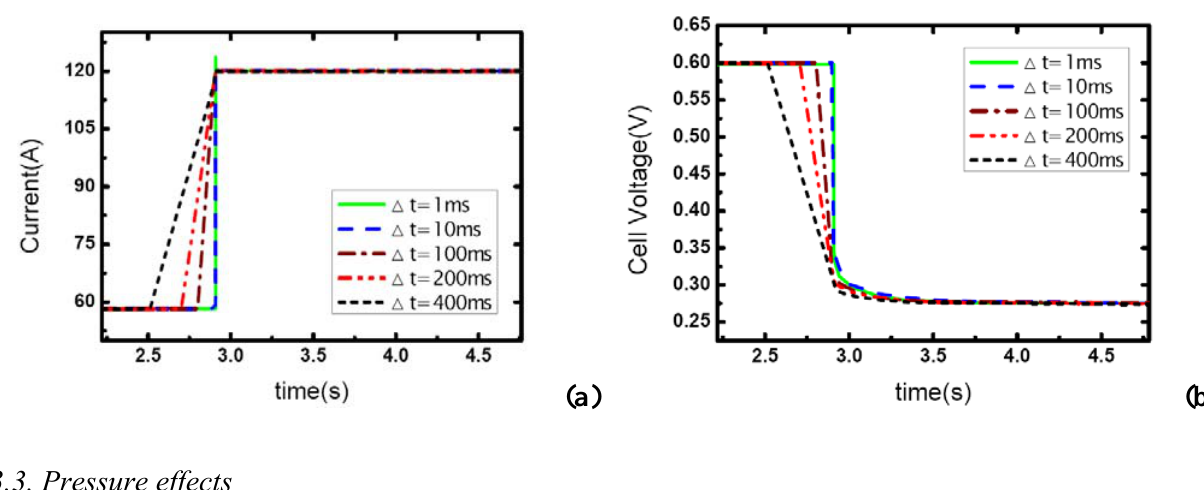
Figure 6. (a) Current change as five different step rates while λ (b) corresponding dynamic responses of